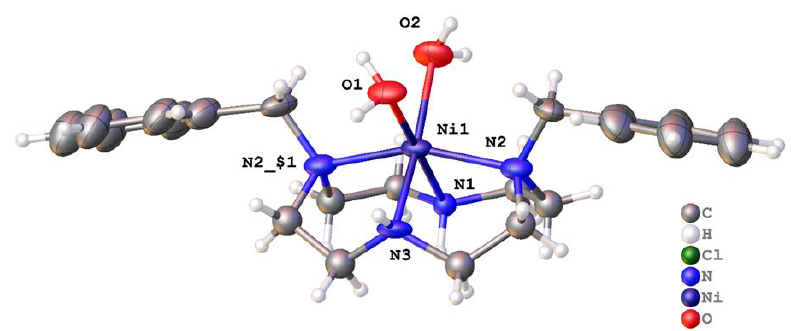
Figure 4. Molecular structure of [Ni( 1 )(OH 2 ) 2 ]Cl 2 . The major disorder component is shown with atoms drawn as 30% probability ellipsoids. For clarity, unbound chloride is not represented. Symmetry operation used for generating equivalent atoms: $1 = y , x , z .